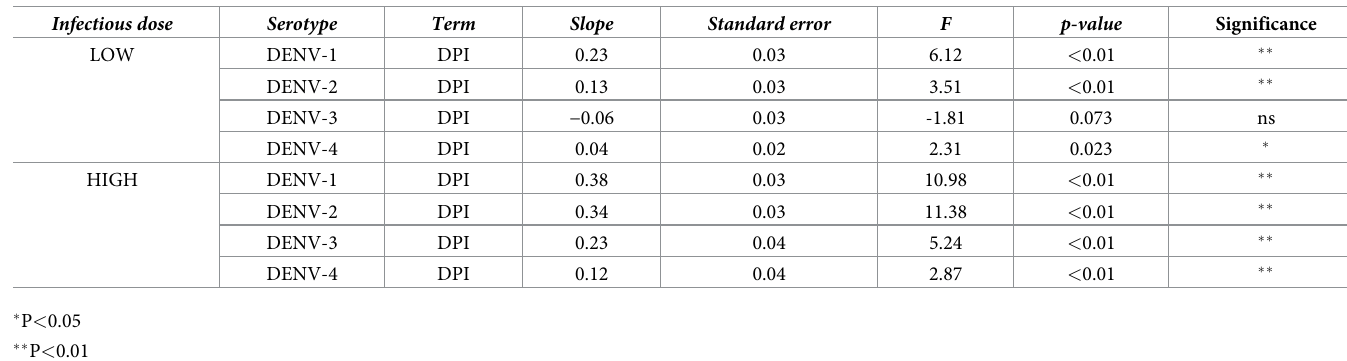
Table 4. Linear regression model for SG. Infectious dose